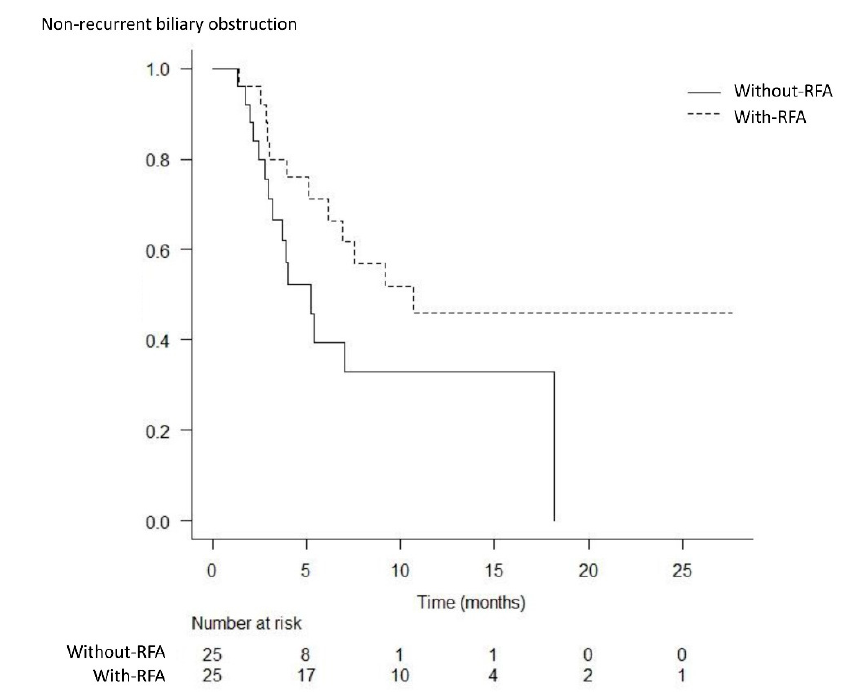
Figure 2. Kaplan–Meier analysis of the time to recurrent biliary obstruction. The median time to recurrent biliary obstruction was significantly longer in the with-RFA group than that in the without-RFA group (10.7 months versus 5.2 months, p = 0.048).